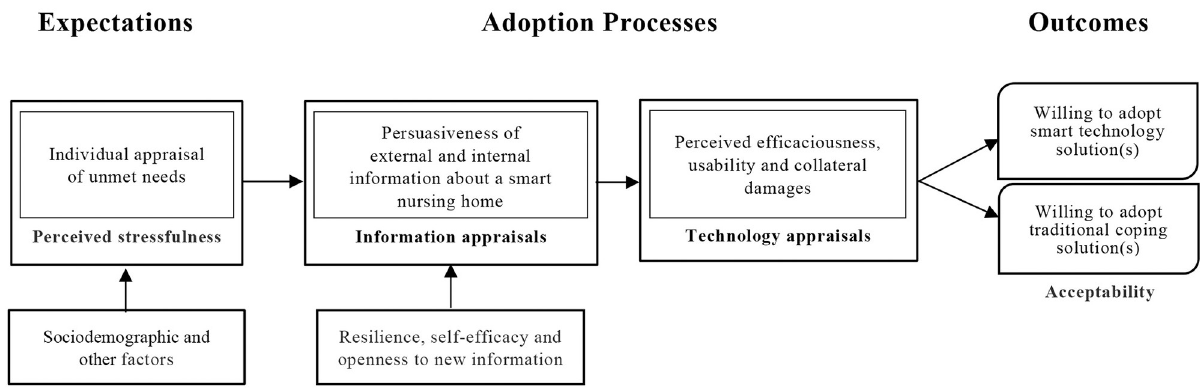
Fig 1. The theoretical model of smart technology adoption behaviours by the elderly